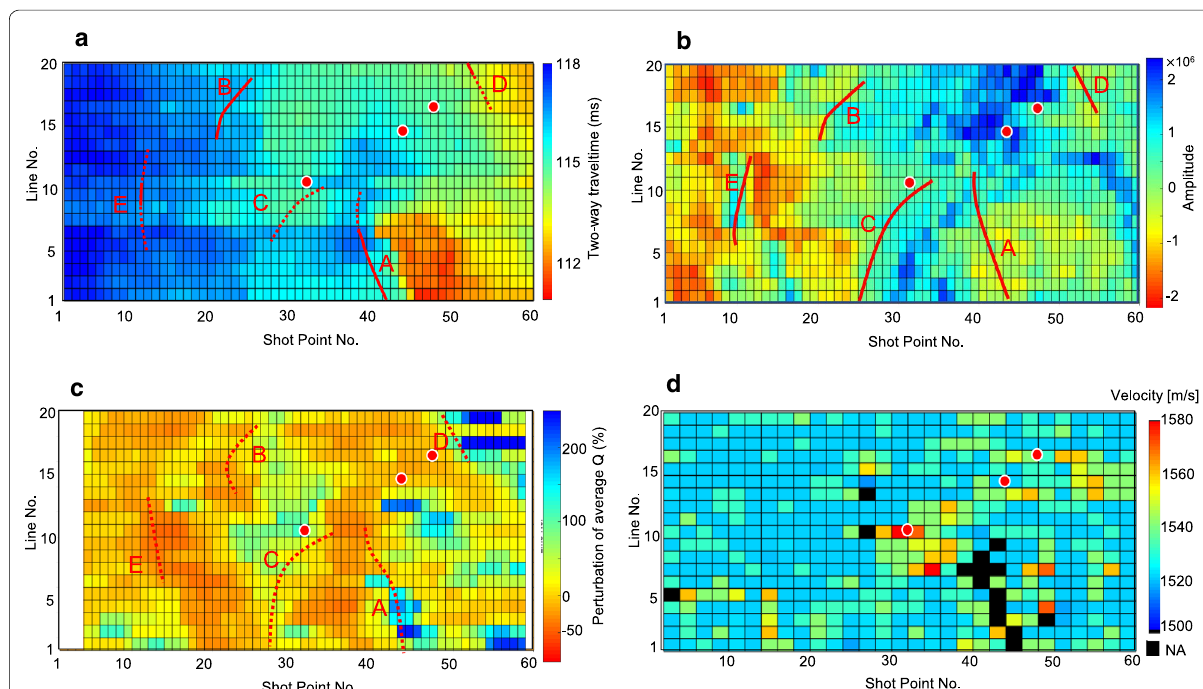
Fig. 13 a Bathymetry from the MCS data. Faults interpreted on the MCS profiles are overlain by solid and broken red lines. Here, the fault segments, where no clear displacement at the seafloor can be observed, are delineated by broken lines. Three red circles mark the location of the EWFs on lines 10, 14, and 16. b Time slice at the two‑way travel time of 140 ms with fault strikes. The faults were mapped where reflection amplitudes rapidly changed laterally. c Q slice at the two‑way travel time of 220 ms with fault strikes. The faults are mapped along zones of high attenuation (red‑to‑yellow colors). d Map view of average velocities of the water column estimated by velocity analysis of the MCS data. The NMO velocities from the velocity analysis (Fig. 7 and Additional file 8) have been corrected by using Levin (1971) equation to remove the effect of dipping